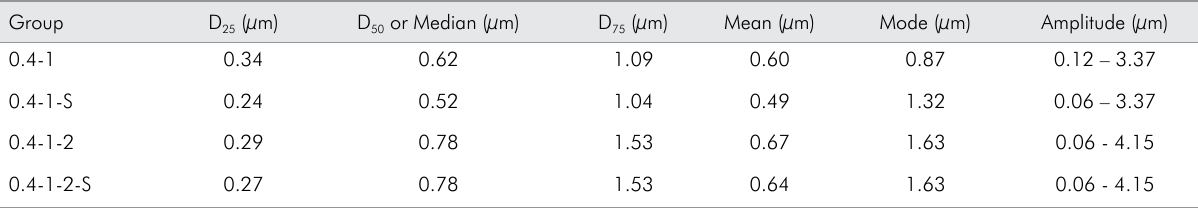
Table 3. Characterization of particle size distribution* for the different filler mixtures. Group D (μm) 25